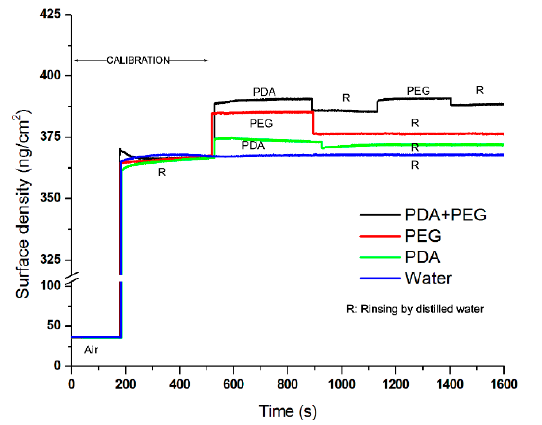
Figure 2. The surface density of quartz crystal with PDA + PEG, PEG, PDA, and water over time. PDA: polydopamine, PEG: polyethylene glycol.